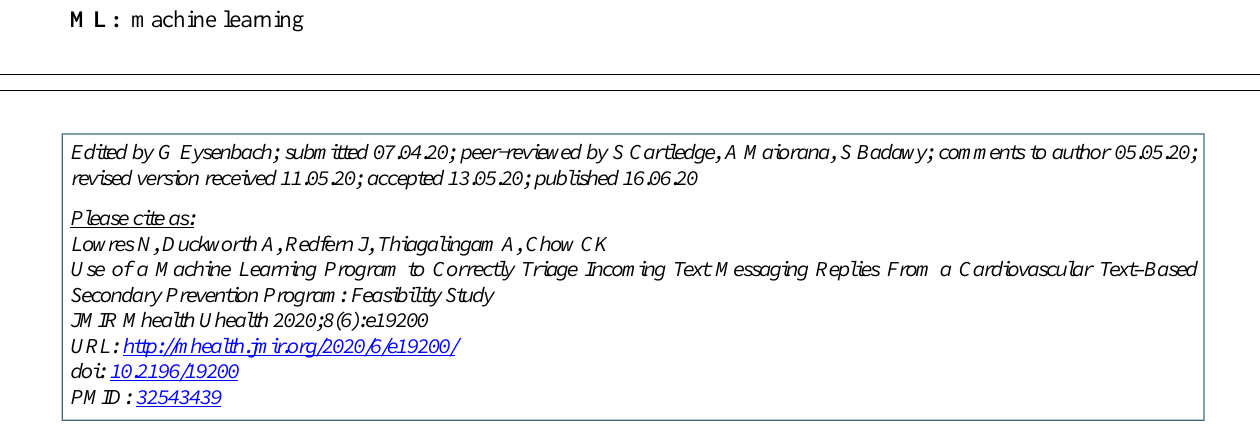
Abbreviations AUC: area under the receiver operating characteristics curve CVD: cardiovascular disease ML: machine